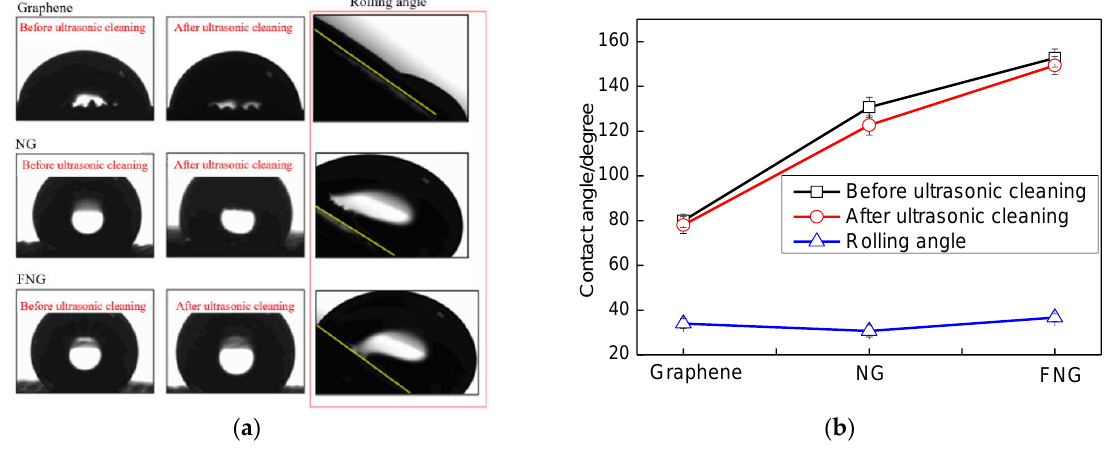
Figure 7. Contact angle measurements: ( a ) optical images of static state water droplets, ( b ) static state WCAs and Rolling state WCAs.